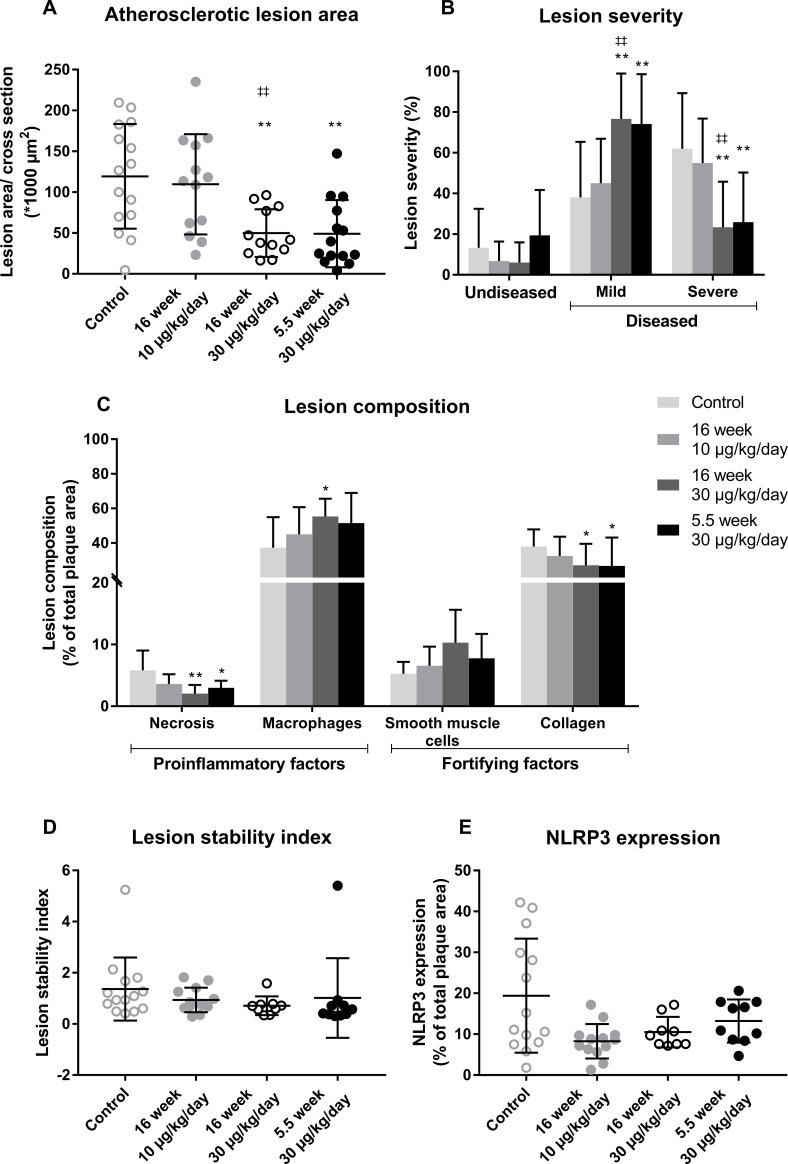
OSM reduces lesion size and severity in APOE*3Leiden.CETP mice.The atherosclerotic lesion size was determined in the aortic root area (A) and the lesions were classified as mild (type I-III) or severe (IV and V) lesions (B). Furthermore, the amount of necrosis, macrophages, smooth muscle cells and collagen was quantified (C) and the lesion stability index was calculated by dividing the summed proportions of SMCs and collagen, as stabilizing factors, by the summed proportions of necrosis and macrophages, as destabilizing factors (D). Additionally, the amount of NLRP3 expression was examined as percentage of the macrophage area (E). Data represent mean ± SD (n = 9–15). The t-test was used for statistical testing of the lesion area. The Kruskal-Wallis test was used to test all other parameters for overall significance. If significant, the Mann-Whitney U test was performed to test which treatment groups were significantly different from the control group. The rejection criteria were adjusted using a Bonferroni-Holm correction *p<0.05 **p<0.01 compared to control; ‡‡ p<0.01 compared to 10 μg/kg/day.